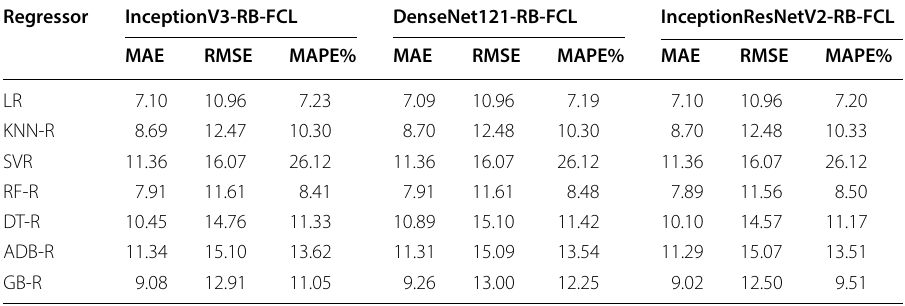
Table 4 Result of Region Based Feature Layer (RB-FCL) output for digital hand altlas